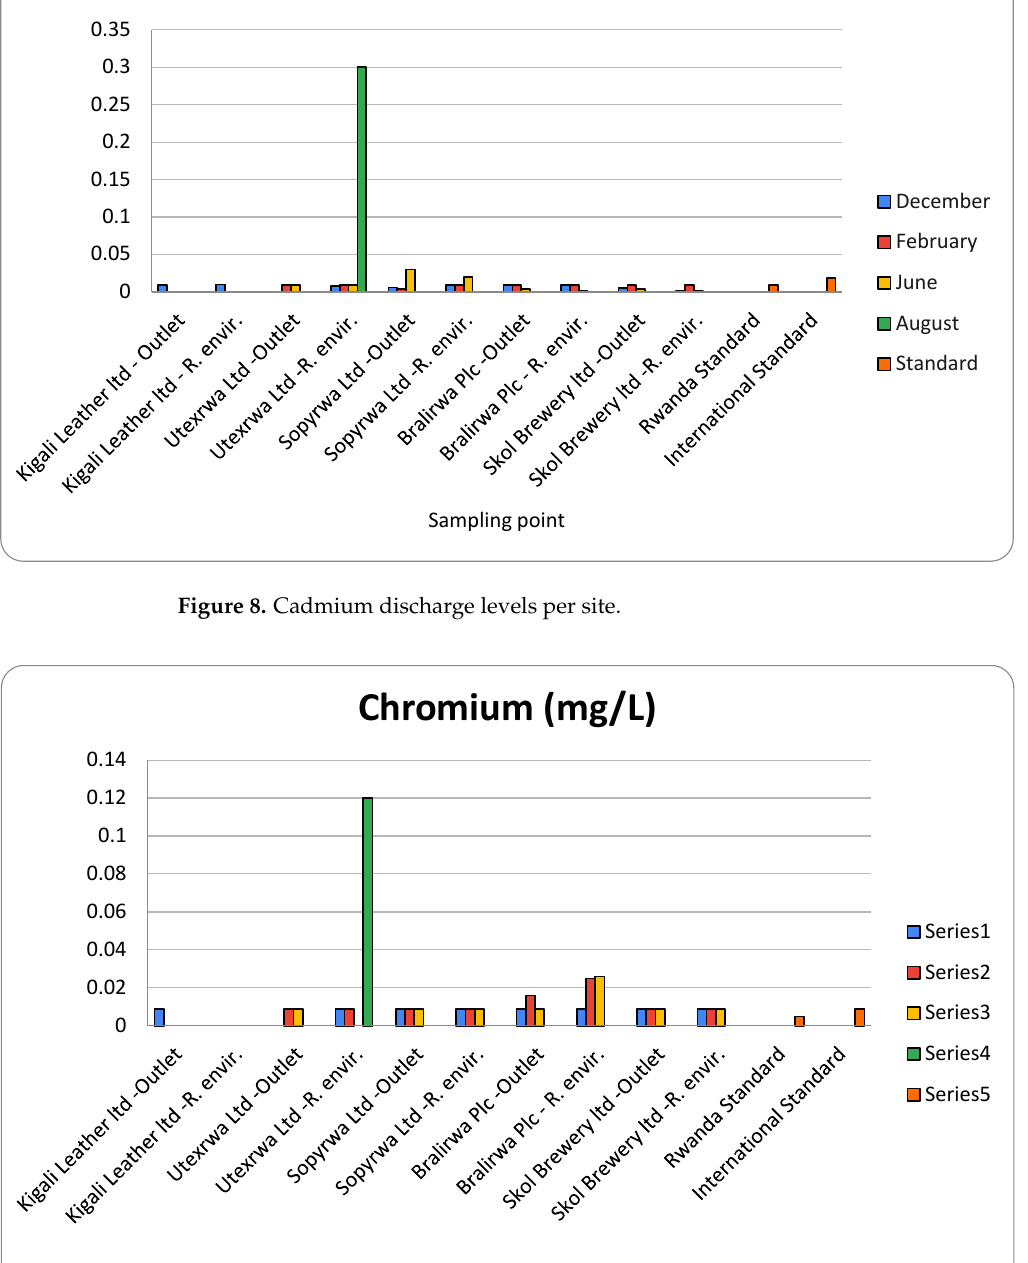
Figure 9. Chromium discharge levels per site .